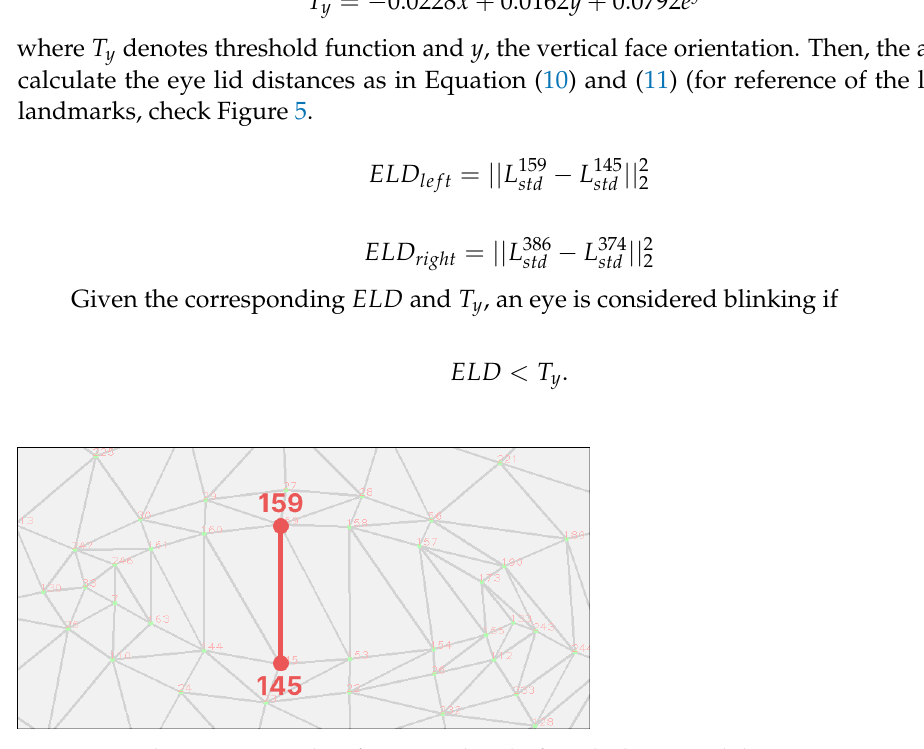
Figure 5. MediaPipe Facemesh Left Eye Landmarks for calculating Eyelid